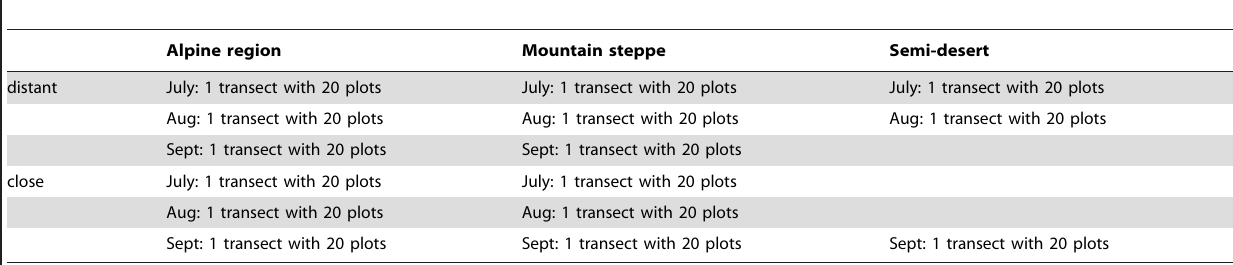
Table 1. Sampling design: 20 plots of 1 m 2 were sampled per month and distance class in the alpine region and the mountain steppe; and 20 plots were sampled per month in the